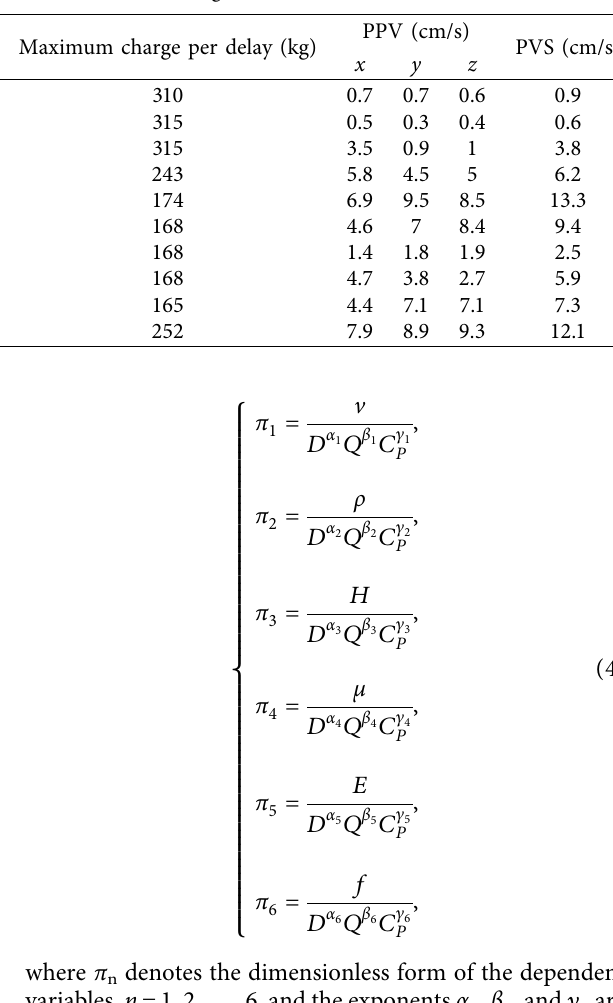
Table 4: Monitoring data on the tunnel surrounding